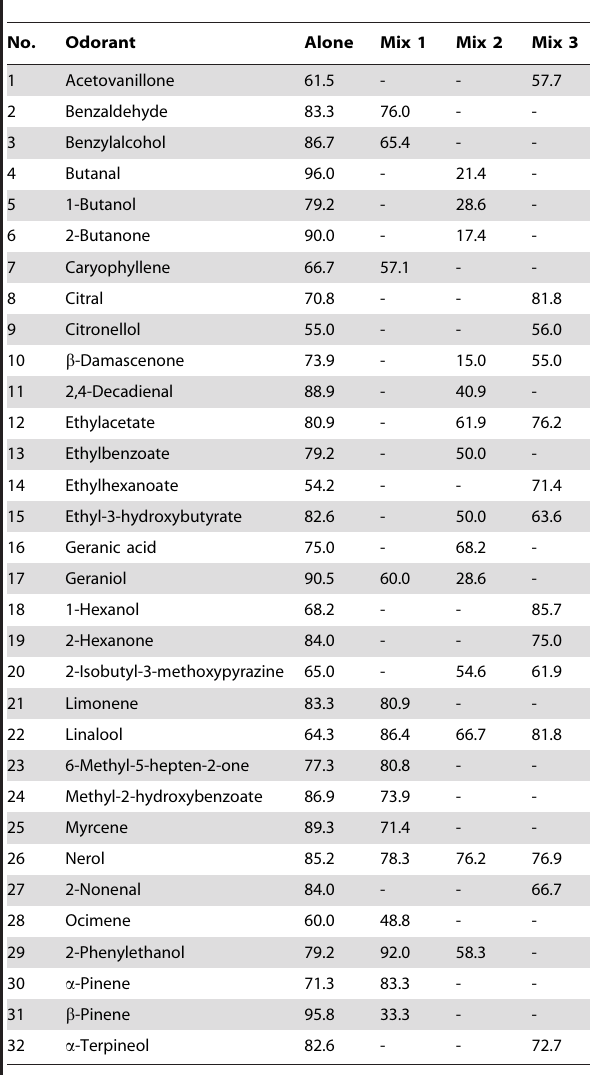
Table 5. Discrimination of Complex Odour Mixtures: PER Response [%].